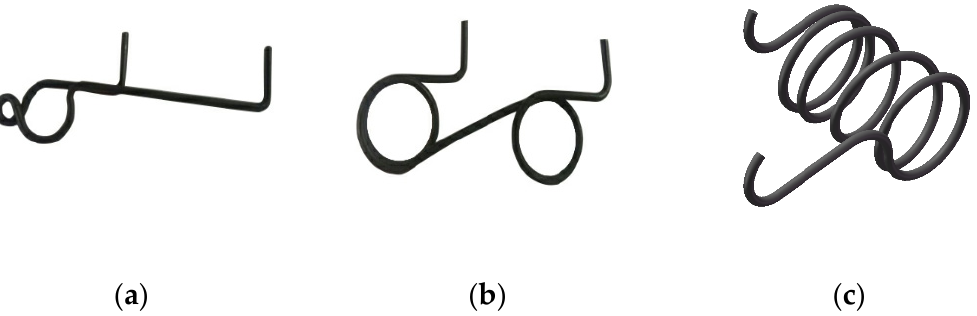
Figure 2. Designed model ( a ) and prototype ( b ) of the conveying device, showing the chains (1), steel bars (2) and elastic teeth (3).